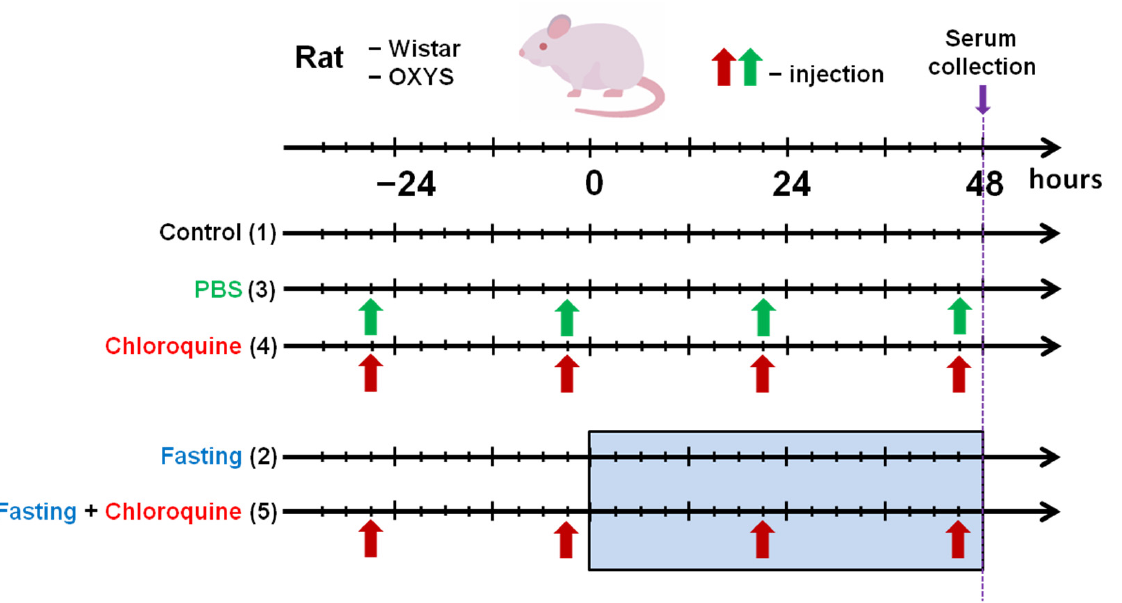
Figure 1. Autophagy experimental design. Five groups of each strain of rats were used: (1) control; (2) 48 h fasting; (3) PBS, i/p injected, vehicle control; (4) CQ, i/p injected; (5) CQ + fasting.